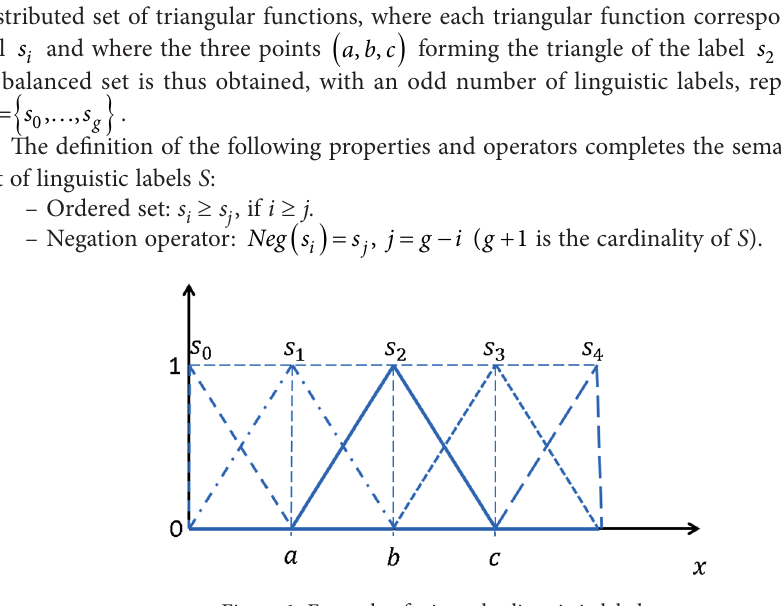
Figure 1. Example of triangular linguistic